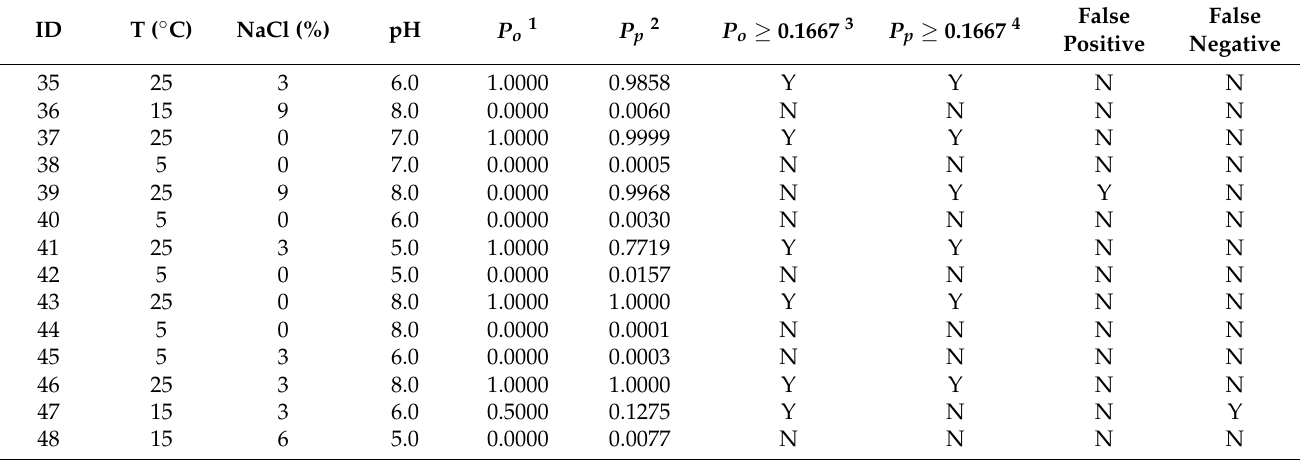
Table 4. Validation of logistic regression model and classification of biofilm formation and no-biofilm formation according to threshold